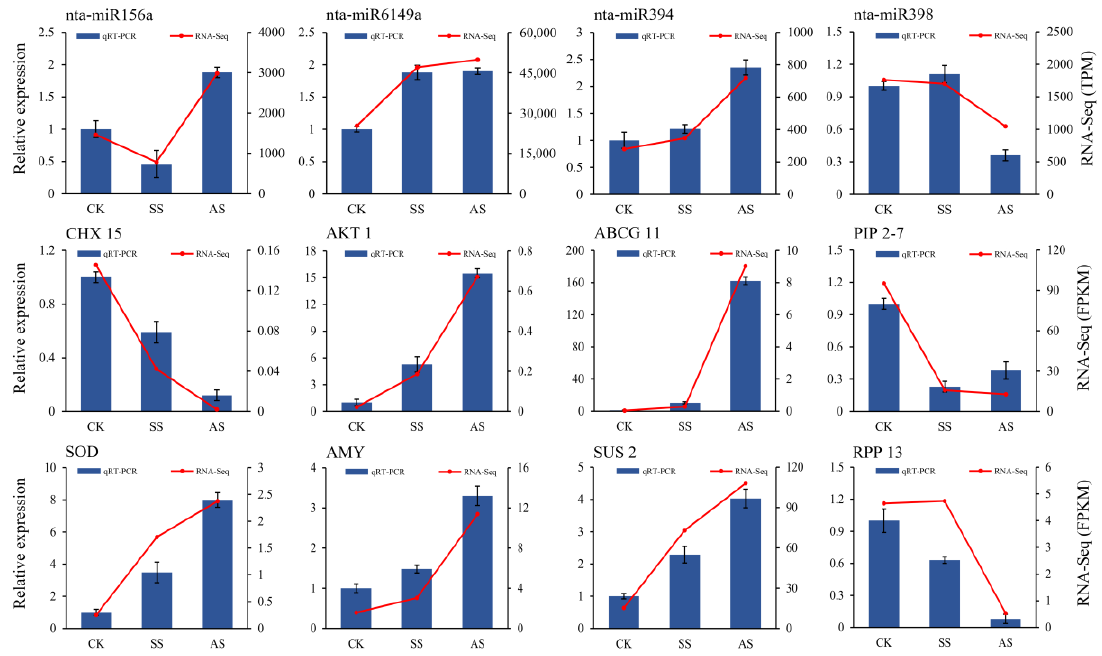
Figure 5. RT-qPCR analysis of miRNAs and mRNAs. The miRNAs and mRNAs were isolated from tobacco treated with NaCl (SS) and NaHCO3 (AS), respectively. The 5.8S rRNA and ef1α genes were chosen as the internal controls for miRNA and mRNA, respectively.